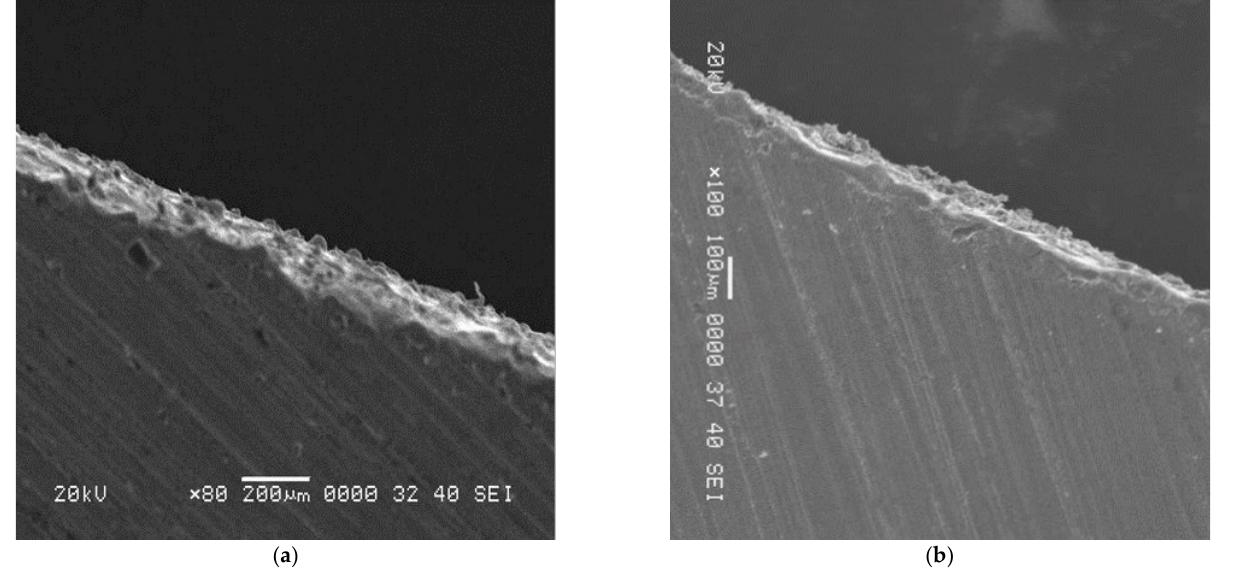
Figure 8. SEM graphs of RLT. ( a ) Highest RLT 68.5 µm observed at particle size of 20 µm and peak current 12 A. ( b ) Minimum RLT 38.7 µm observed at particle size of 20 µm and peak current 9 A.